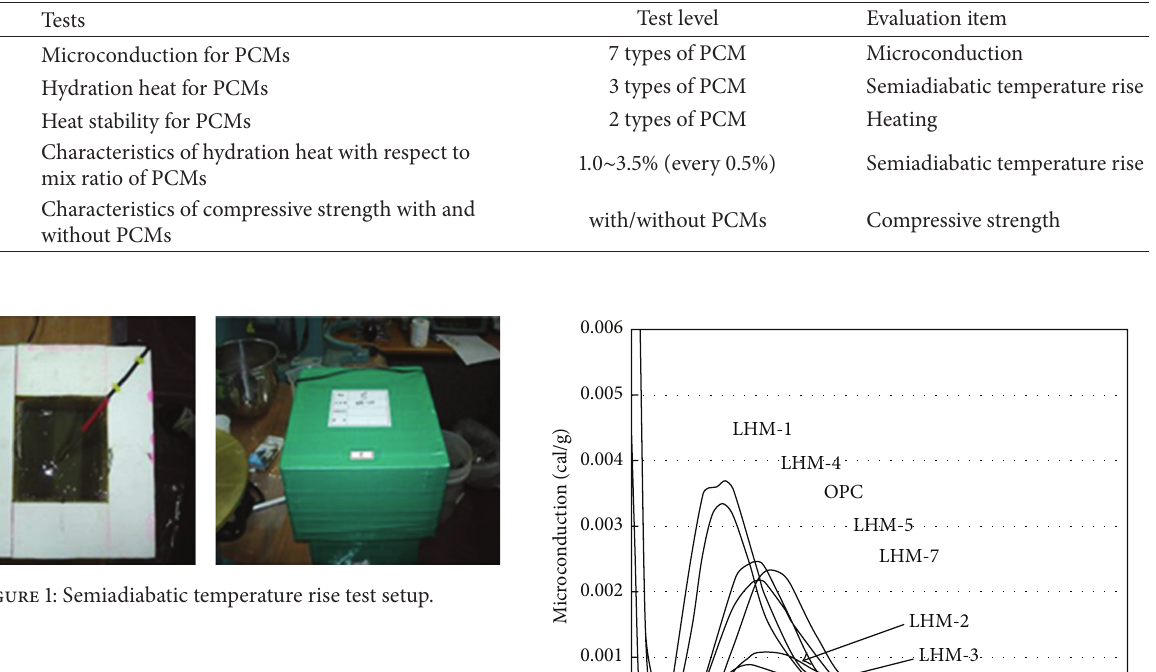
Table 3: Summaries of tests.